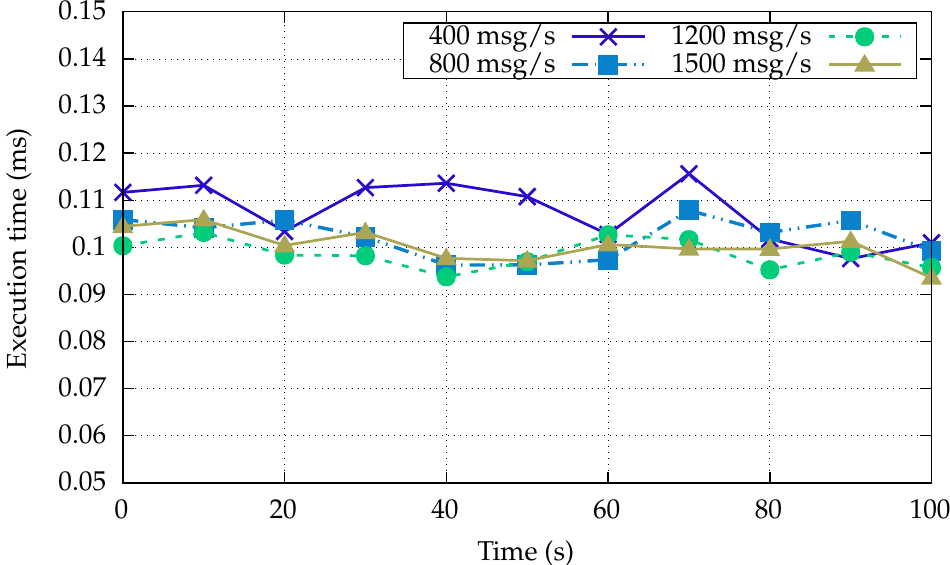
Figure 3. Machine-to-machine communication latency under varying message load of the OT layer.